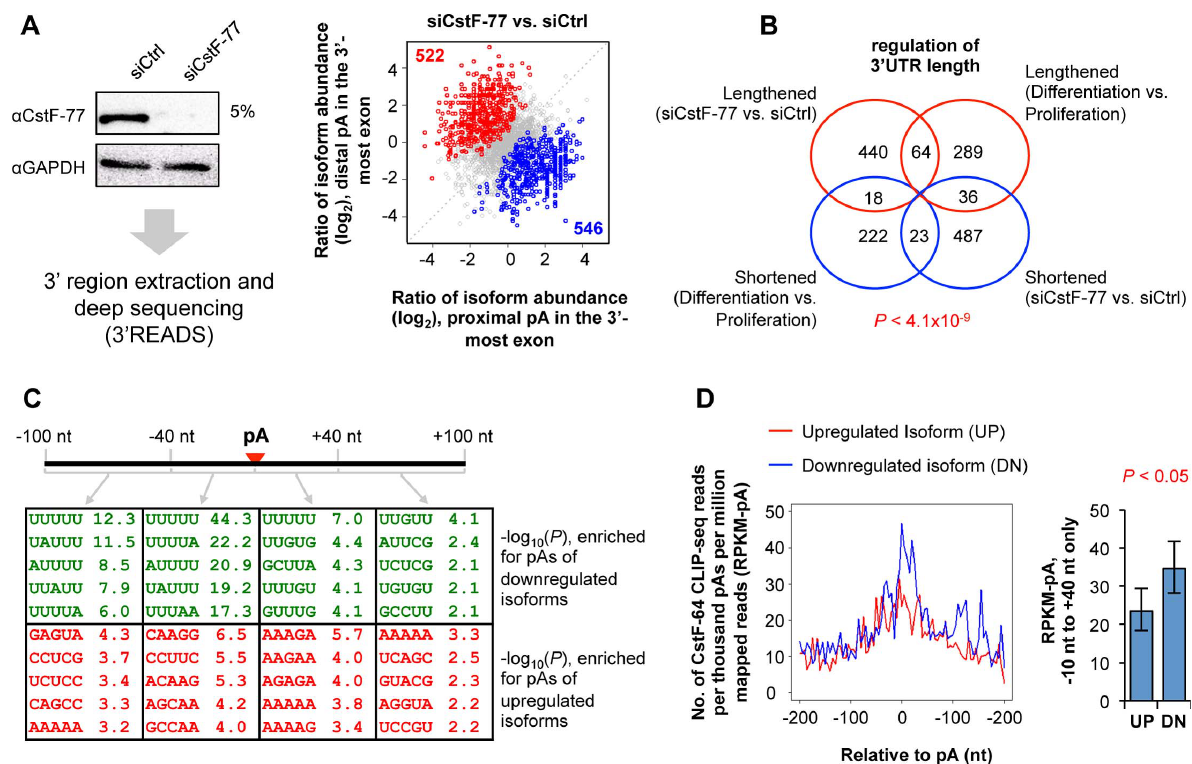
Figure 7. Knockdown of CstF-77 leads to widespread APA events. ( A ) Analysis of effect of CstF-77 knockdown in proliferating C2C12 cells by 3 9 READS. Left, IB of CstF-77 knockdown; right, regulation of alternative pAs in the 3 9 -most exon after CstF-77 knockdown. Genes with significantly upregulated distal (red) and proximal (blue) pA isoforms are indicated in each graph along with total numbers. Significantly regulated isoforms are those with P , 0.05 (Fisher’s exact test) and abundance change . 5%. Only the two most abundant isoforms for each gene were analyzed. ( B ) Comparison of genes with 3 9 UTR changes between CstF-77 knockdown and C1C12 differentiation. The number of consistently regulated genes is significantly greater ( P =4.1 6 10 2 9 , Chi-squared test) than the number of oppositely regulated ones. ( C ) Pentamers enriched for pAs of downregulated isoforms (top) and of upregulated isoforms (bottom). ( D ) CstF-64 binding around the pAs of upregulated isoforms (UP) and downregulated isoforms (DN). Left, binding profiles representing the number of CstF-64 CLIP-seq reads per thousand pAs per million mapped reads; right, aggregated reads in the 2 10 nt to + 40 nt region around the pA. The difference between UP and DN groups is significant ( P , 0.05, bootstrap analysis).